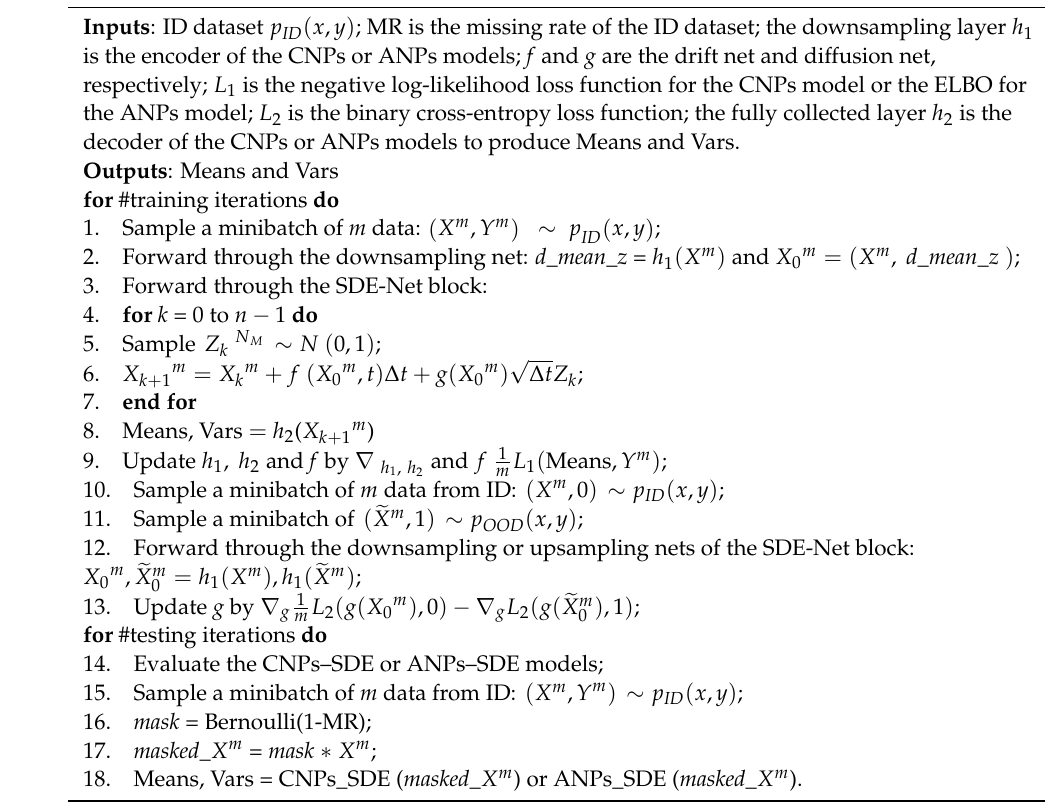
Algorithm 2 Implementation of the CNPs–SDE or ANPs–SDE